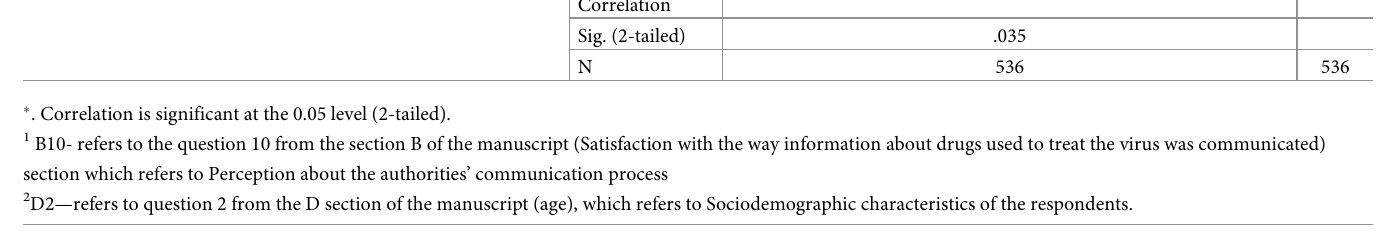
D2 2 . Age Pearson